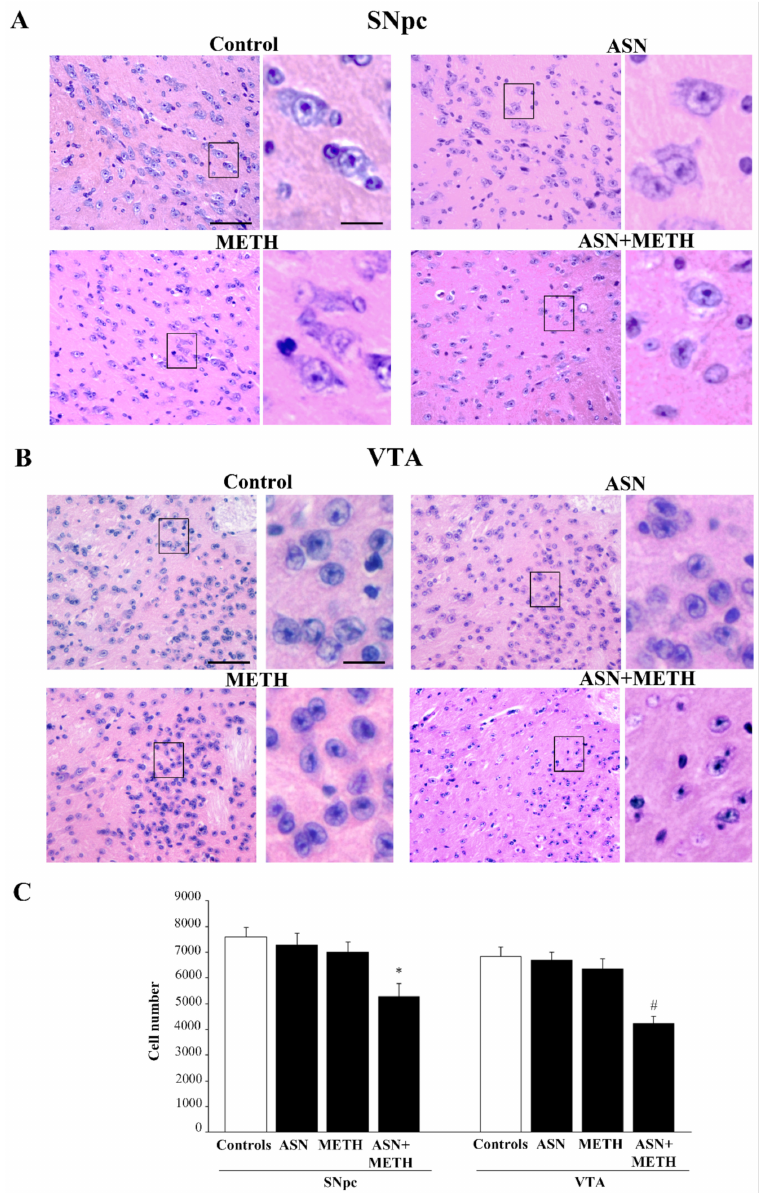
Figure 5. Combined ASN + METH reduces the number of cell bodies within both SNpc and VTA. Combined treatment ASN + METH reduces the number of cells within SNpc and VTA. Repre- sentative H&E-stained pictures from SNpc ( A ) and VTA ( B ). Images at high magnification refer to black-squared areas of the related low magnification pictures. ( C ) The histogram reports the number of H&E-stained cells counted within both areas according to stereology-like procedure. * p < 0.05 compared with Controls; # p < 0.05 compared with Controls and METH. Scale bar (low magnification) = 80 µ m; scale bar (high magnification) = 18 µ